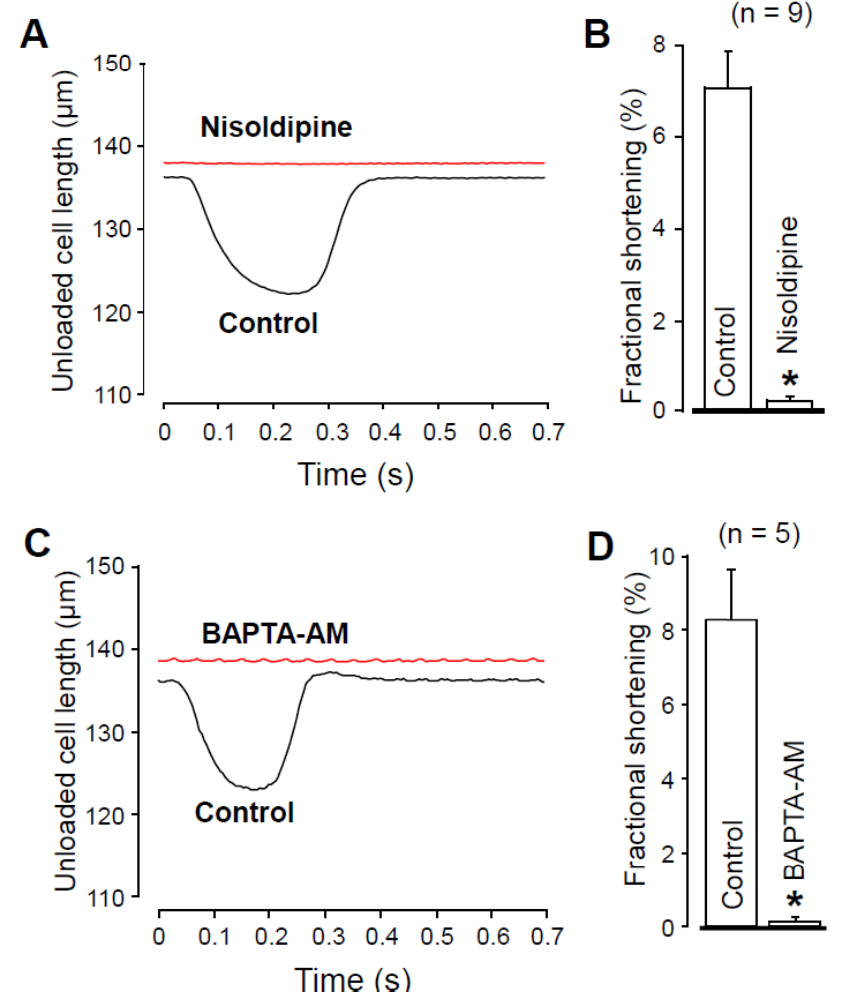
Figure 5. Recording of unloaded cell shortening in the absence and presence of 1 µM nisoldipine ( A , B ) and after superfusion with 5 µM BAPTA-AM for 30 min ( C , D ). ( A , C ) Representative superimposed records of unloaded cell length. Downward deflection indicates cell shortening. ( B , D ) Average results of fractional cell shortening. Columns and bars are mean ± SEM values, numbers in parentheses indicate the number of myocytes studied, asterisks denote significant differences in control and post-drug data.